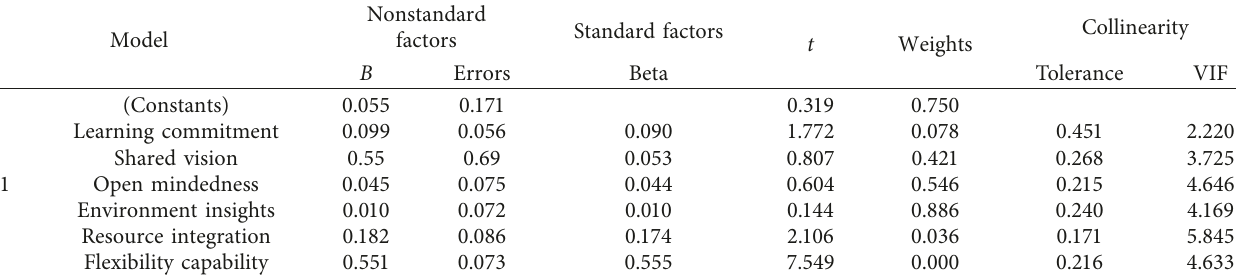
Table 2: VIF test results of each dimension.